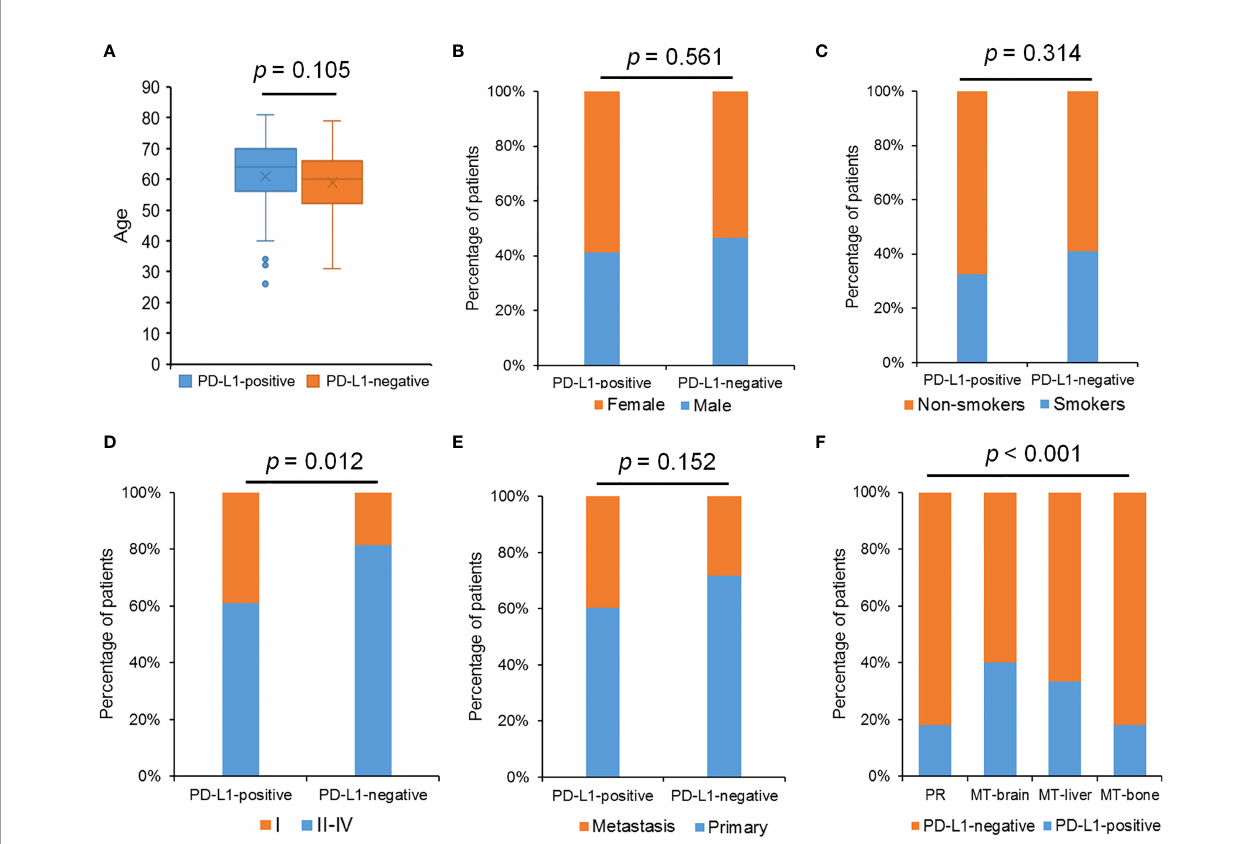
FIGURE 7 | The relationship between PD-L1 expression and clinical features. (A) The relationship between PD-L1 expression and age. (B) The percentage of patients with different gender in the PD-L1 – positive group and the PD-L1 – negative group. (C) The percentage of patients with smoking history in the PD-L1 – positive group and the PD-L1 – negative group. (D) The percentage of patients with different pathological stages in the PD-L1 – positive group and the PD-L1 – negative group. (E) The percentage of patients with different tumor status in the PD-L1 – positive group and the PD-L1 – negative group. (F) The percentage of patients with different tumor metastasis status in the PD-L1 – positive group and the PD-L1 – negative group. The Chi-square test was used to detect p -values, and p -value ≤ 0.05 was recognized statistically signi fi